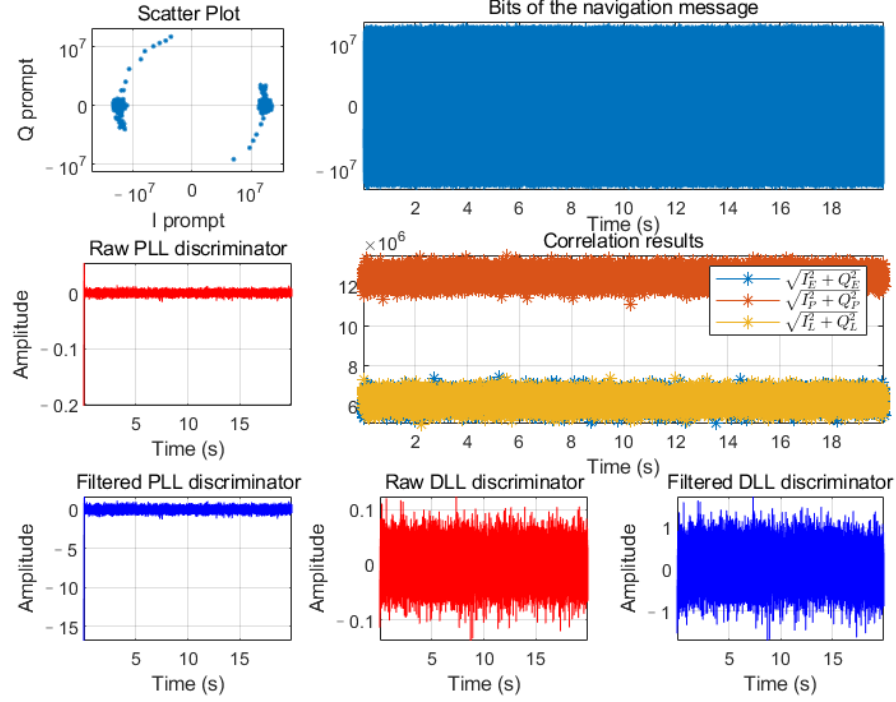
Figure 17. Tracking results of the proposed strategy (C/N 0 = 60 dBHz, D = 1).